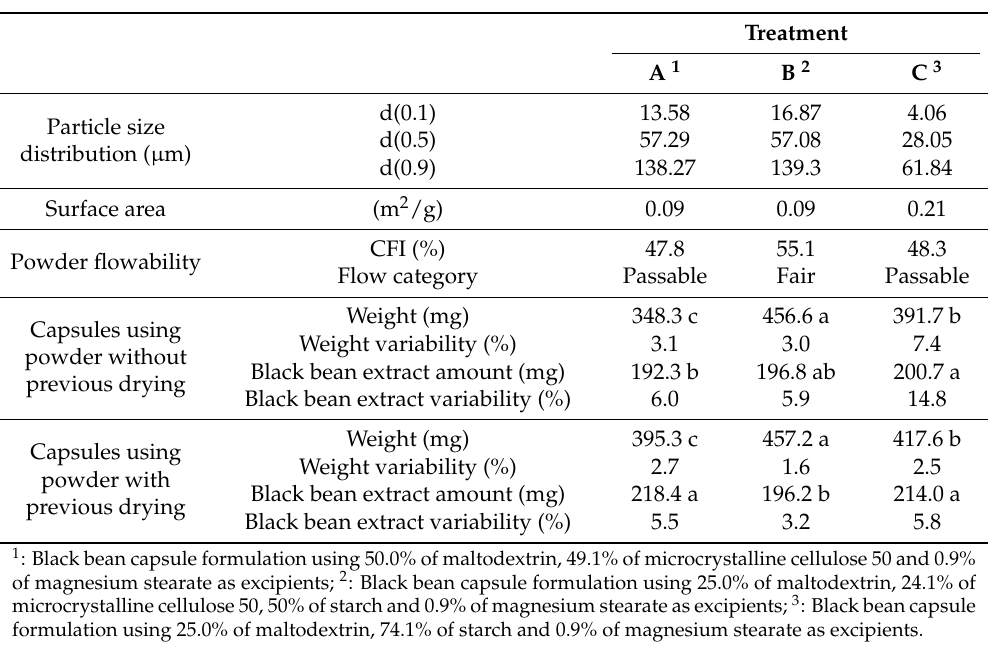
Table 5. Physical properties and flowability of black bean formulation and the effect of a drying prior encapsulation on capsule weight and black bean extract content.